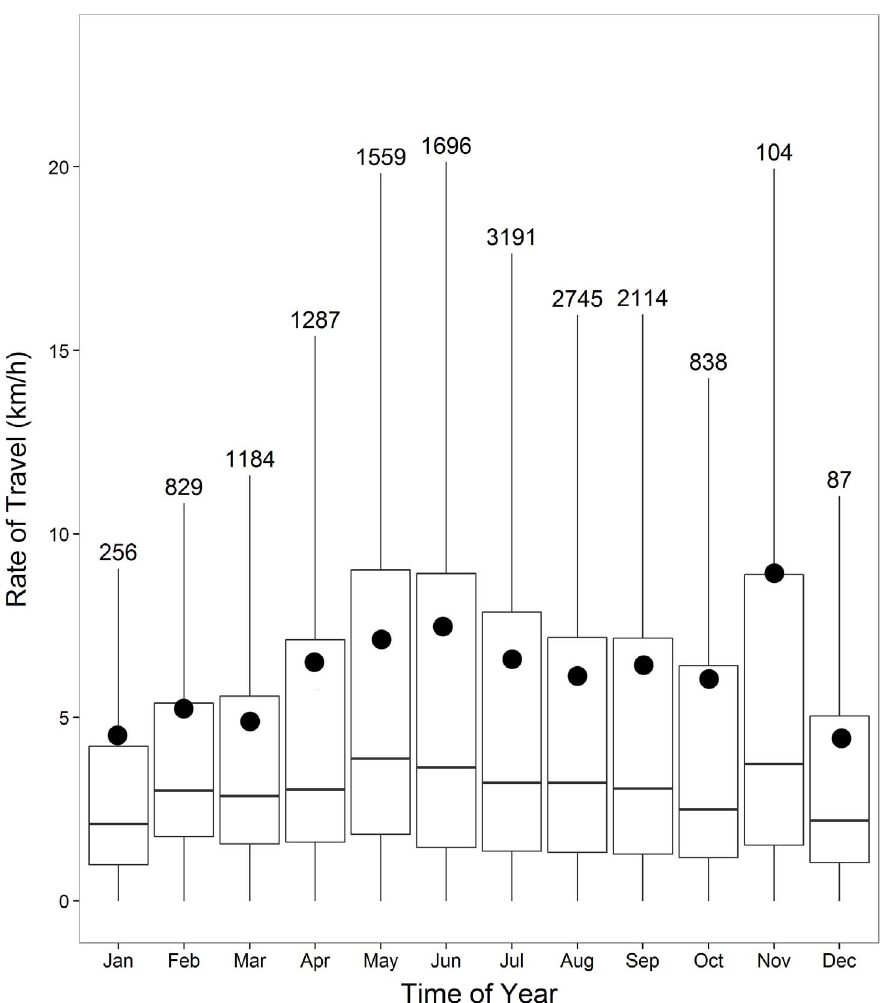
Fig. 5. Hourly rates of travel (km/hr) per month. Box plots show median and 25 th and 75 th quartiles for all satellite-tagged ivory gulls throughout the study period, July 2010- July 2013. Whiskers represent values within 1.5 times the interquartile range. Mean values are depicted by the black circles. Note small sample size for November and December due to too few records during the blackout period for the